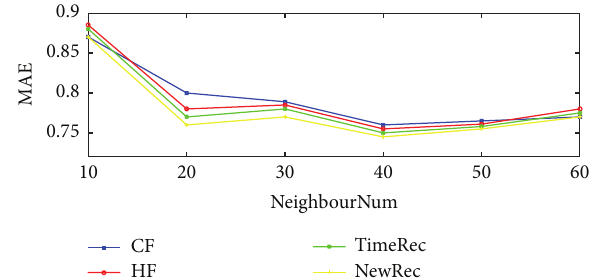
Figure 6: Influences of the number of user neighbors on accuracy.